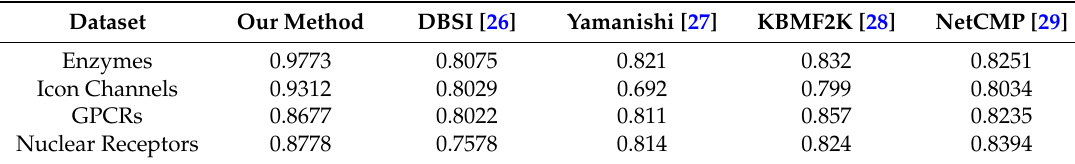
Table 7. Comparison of predicting performance between our method and other methods on four